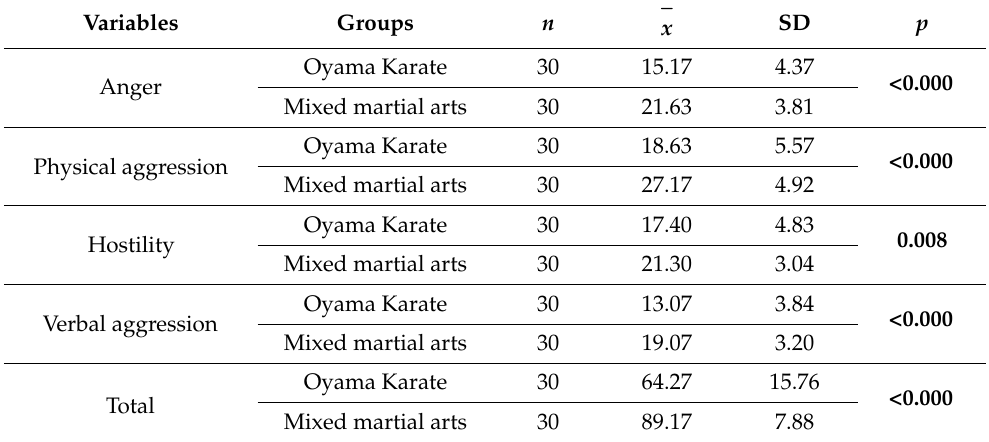
Table 2. Different types of aggressiveness and the levels of hostility and physical and verbal aggression. Variables Groups